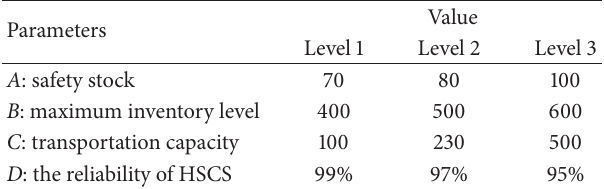
Table 1: The parameter levels in this